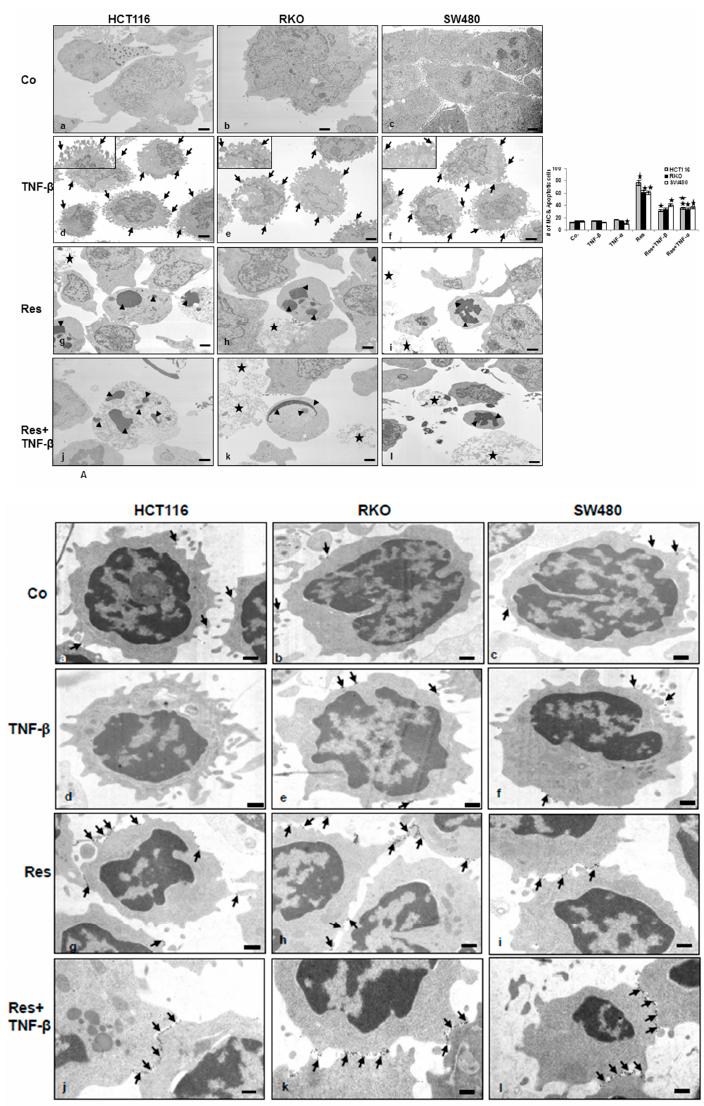
Figure 2. Electron microscopic observation of cell-surface and cell-morphology in CRC cells after treatment with TNF- β or/and resveratrol. HCT116, RKO, and SW480 were cultured in a monolayer culture and were untreated ( a–c ), or treated with TNF- β ( d–f ) or TNF- α with resveratrol ( g–i ) alone, or with TNF- β and co-treated with resveratrol ( j–l ), or TNF- α and co-treated with resveratrol, as described above and investigated with a transmission electron microscope. ( A ) Untreated control (Co) tumor cells showed a planar surface and moderate microvilli (arrows) on the cell surface (a–c). By contrast, treatment with TNF- β or TNF- α resulted in alteration of cell surface ultrastructure and cells contained abundant, long microvilli and filopodia-like structures on the cell surface (d–f). By contrast, treatment of tumor cells with resveratrol alone (g–i) or co-treated cells with resveratrol and TNF- β (j-l) displayed only a few microvilli, with an overall planar surface. Tumor cells became rounded and the nucleus contained more heterochromatin, multiple vacuoles, and swelling of cell organelles like mitochondria. Apoptotic bodies (arrowheads) and cell lysis (*) was visible. a–l: Magnification, 5000x. Scale bar = 1 µ m. Insets: Scale bar = 0.09 µ m. To quantify mitochondrial changes (MC) and apoptosis in tumor cells, 100 cells from 25 microscopic fields were counted. Values were compared with the control and statistically significant values with p < 0.05 were designated by (*) and p < 0.01 were designated by (**). ( B ) Effect of resveratrol on E-cadherin expression in CRC cells shown by immunoelectron microscopy. Immunogold labeling (arrows) is observed at the plasma membrane of CRC cells with antibodies against E-cadherin. Scale bars = 0.2 µ